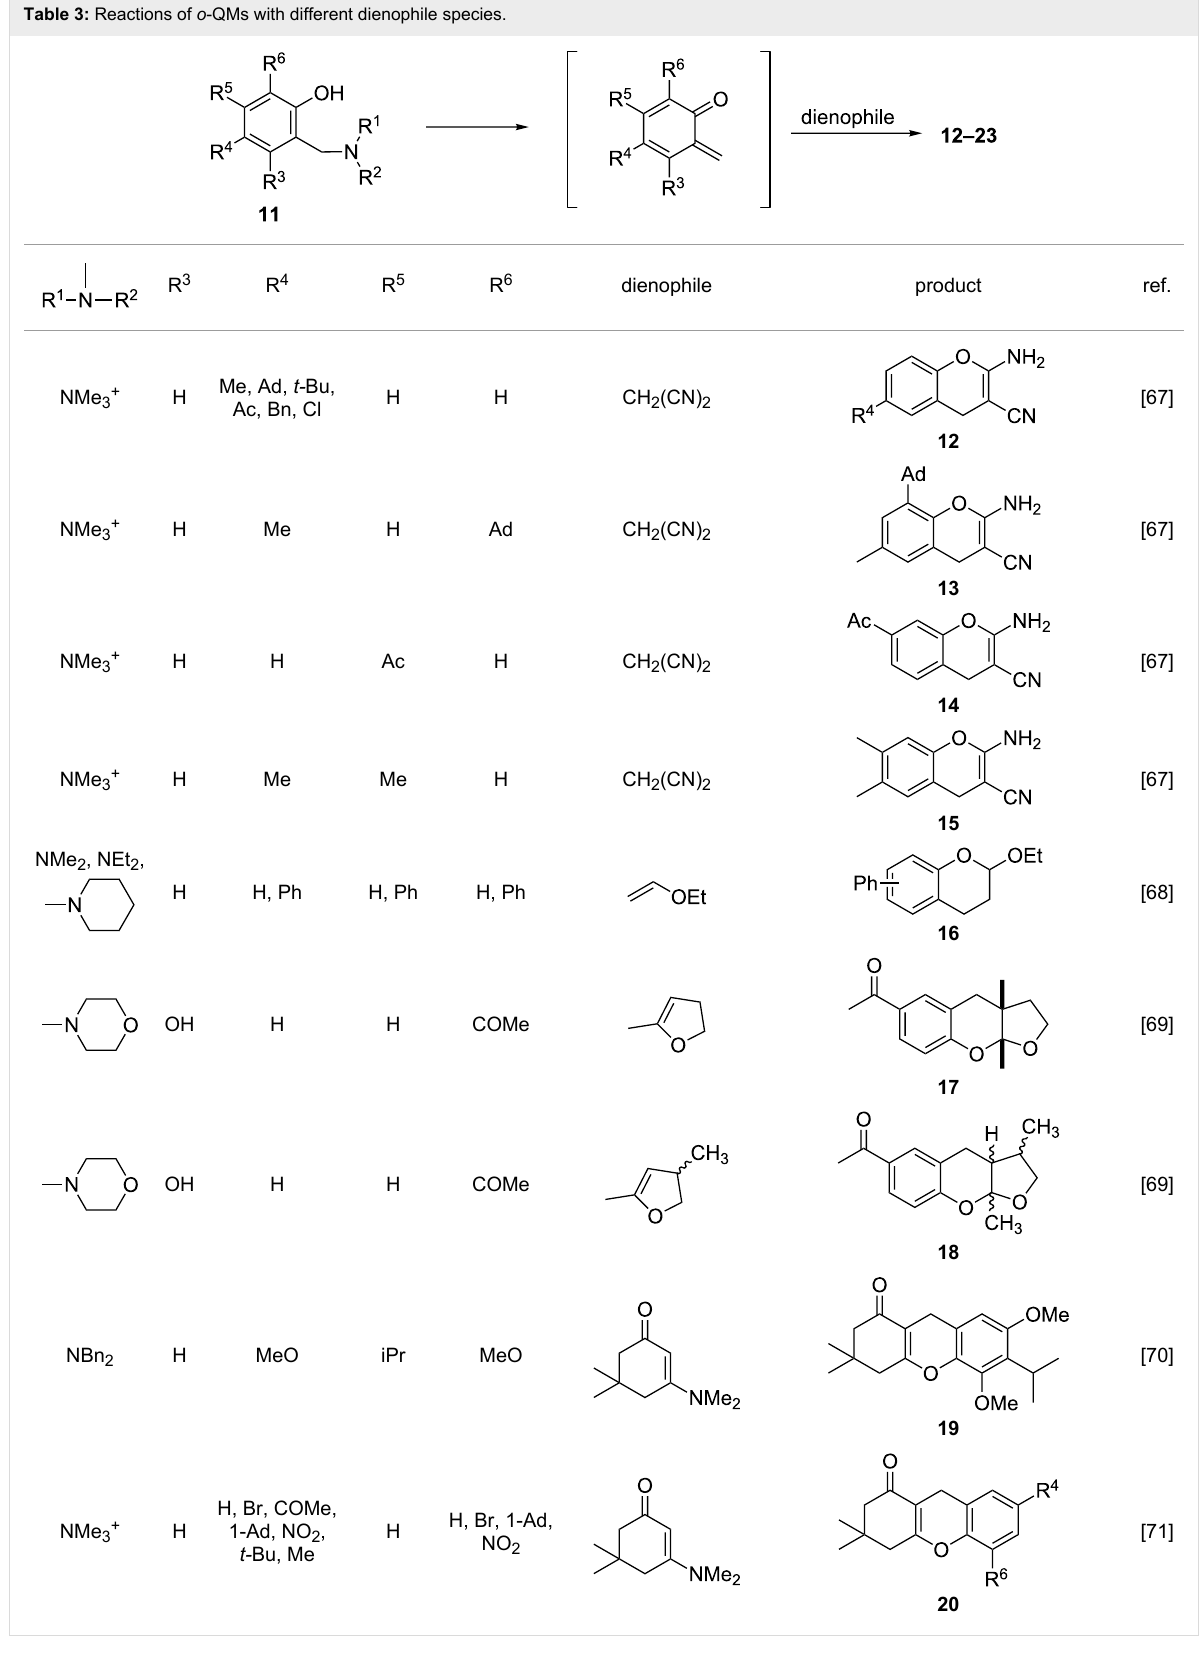
Table 3: Reactions of o -QMs with different dienophile species.